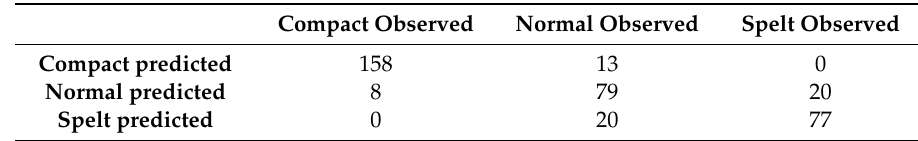
Table 7. Confusion matrix for classification of spike shape in the test sample of images (see Table 2) in four projections (‘clip’